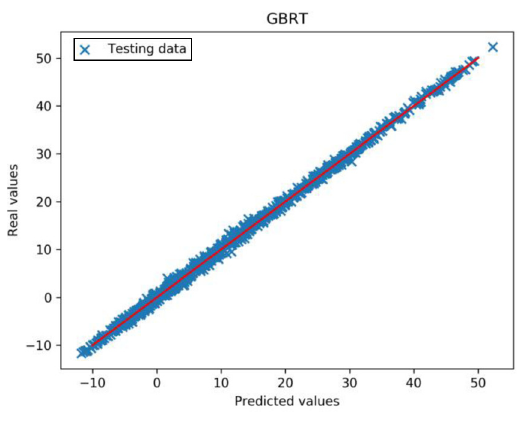
Figure 8. Line chart of real value and predicted value with Lasso